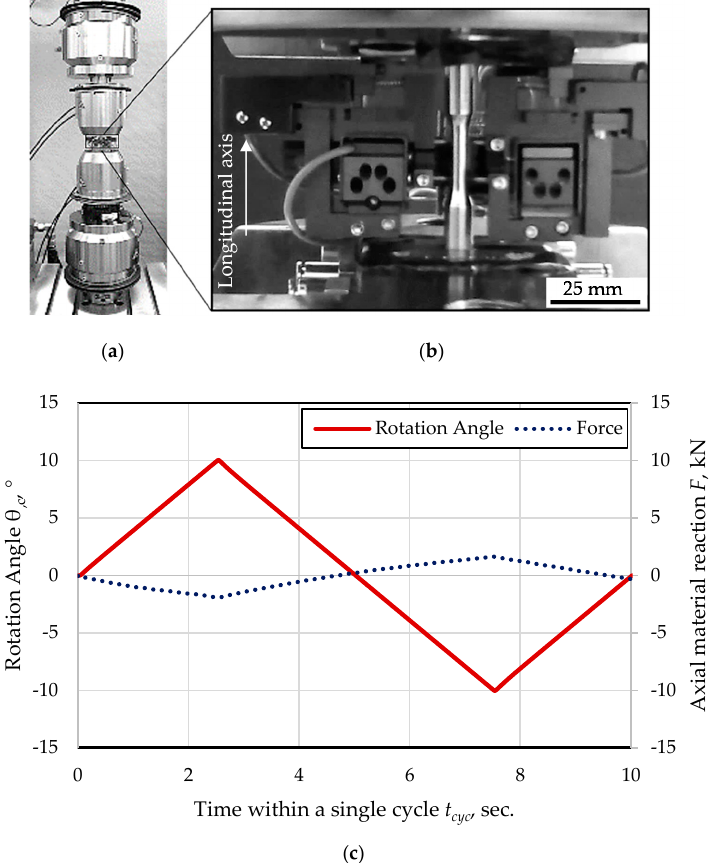
Figure 3. ( a ) Testing system Walter + Bai LFV-T250 T2500 HH; ( b ) testing set-up with specimen, axial-torsional extensometer type Epsilon ® Tech 3550-010M-020-004-ST with gauge length l gau = 10 mm used for cyclic forward-reverse torsion tests with fixed specimen length; ( c ) Load path in rotation control and resulting axial material